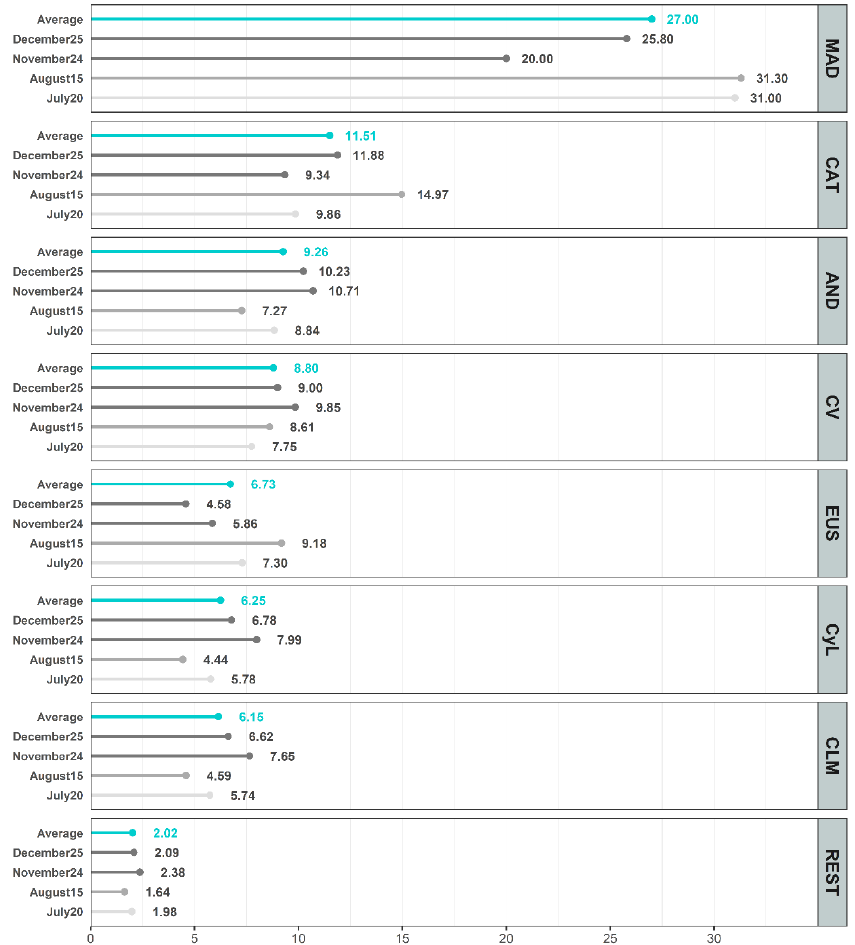
Figure 4. Mobility of residents to other autonomous communities. Compiled by the authors using data from the INE corresponding to the pilot study, “Mobility studies using mobile telephones” [53]. The percentage refers to the number of travellers from the reference community to other communities with respect to the total number of travellers per day. The acronyms refer to the following autonomous communities: MAD (Madrid), CAT (Cataluña), AND (Andalucía), CV (Comunitat Valenciana), EUS (País Vasco), CyL (Castilla y León) and CLM (Castilla La Mancha). REST (the rest of the autonomous communities) aggregates the average of the remaining 12 Spanish regions. The dates chosen correspond to public holidays.